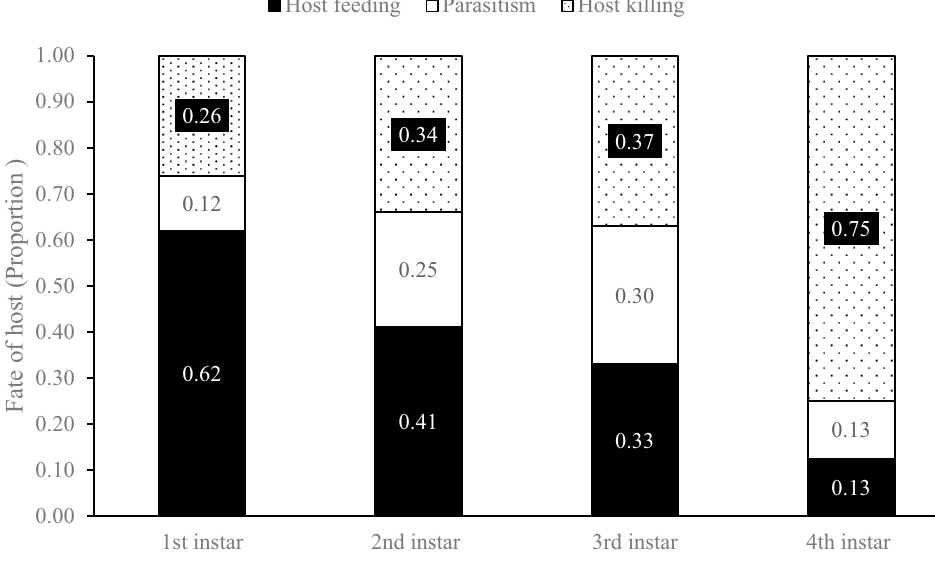
Figure 1. Behavioral shift among host feeding, parasitism and host killing of Necremnus tutae females when different instars of Tuta absoluta larvae were offered . The numbers in the bars indicate the proportion of the number of hosts killed by each behavior (host feeding, parasitism and host killing) in total host